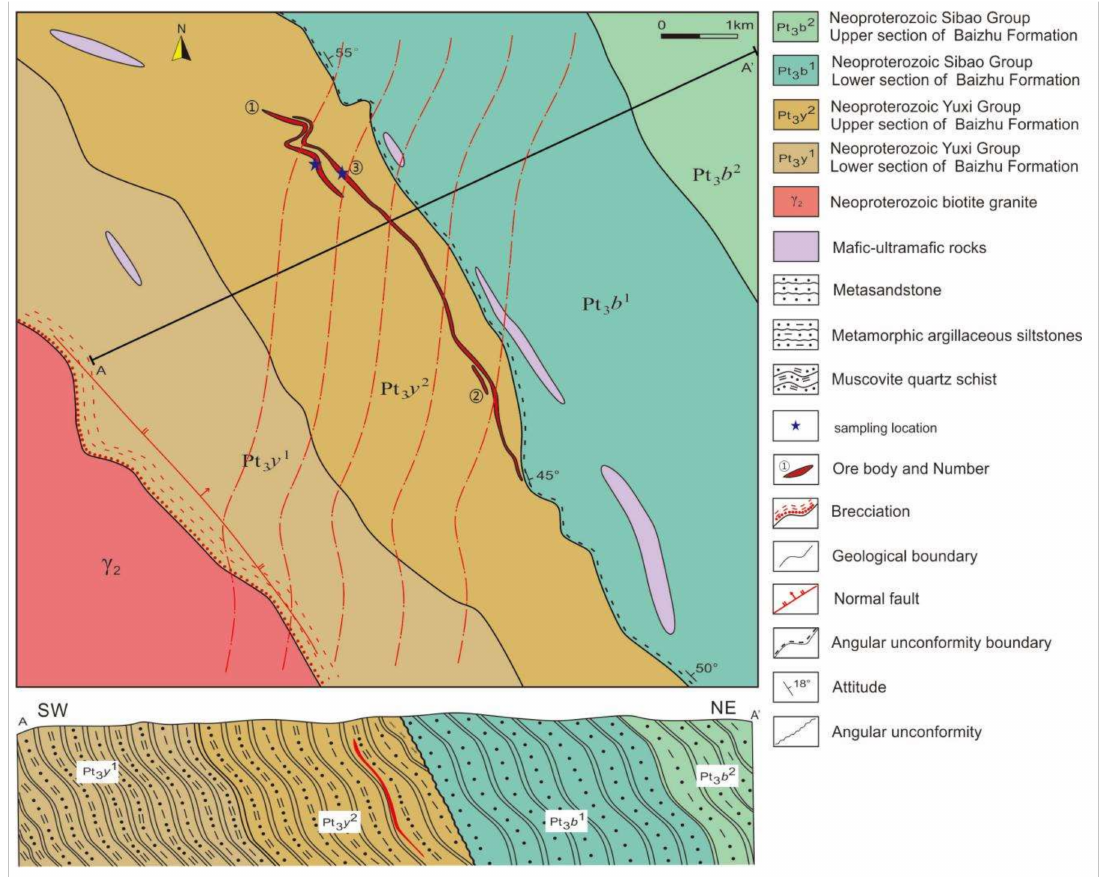
Figure 2. Geological map of the Jialong Cu–Sn deposit [16] (modified after Bureau of Geology and Mineral Resources of Guangxi